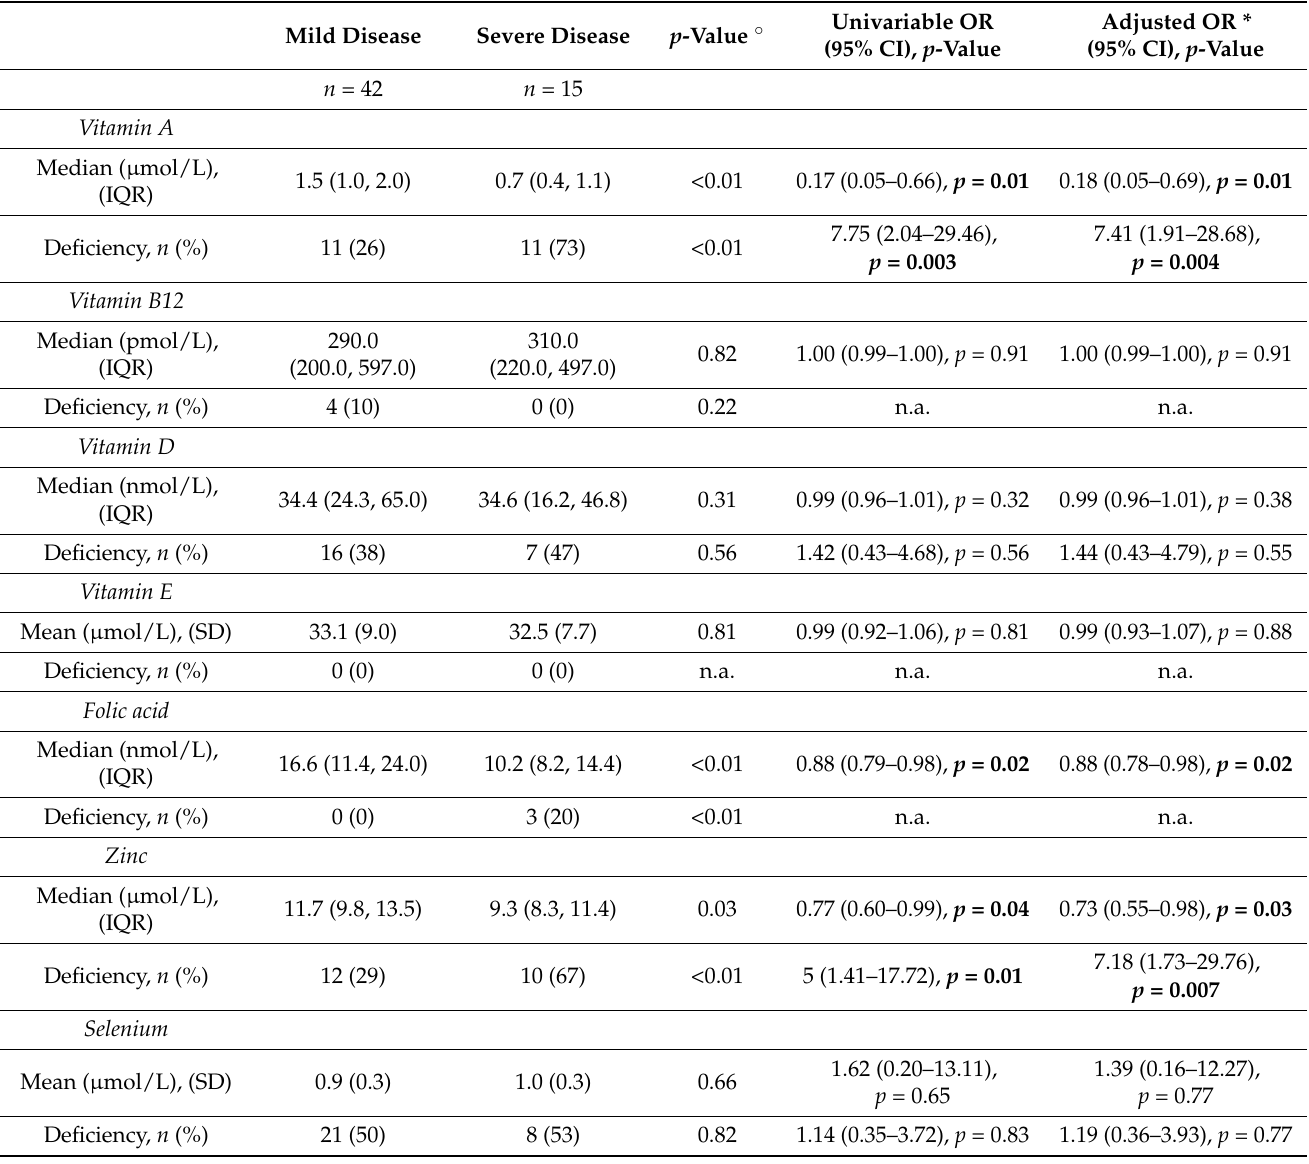
Table 3. Micronutrient levels stratified by composite endpoint and crude and adjusted association of micronutrient levels and composite endpoint of ICU admission and/or in-hospital